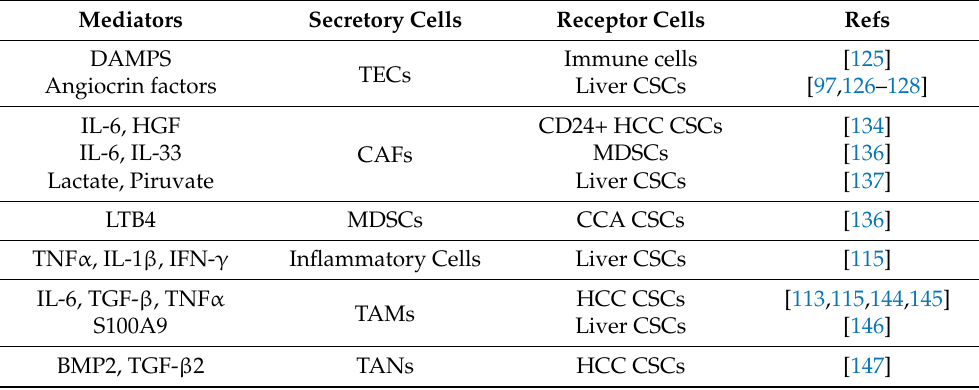
Table 1. TME-derived factors that play a role in the regulation of liver CSC